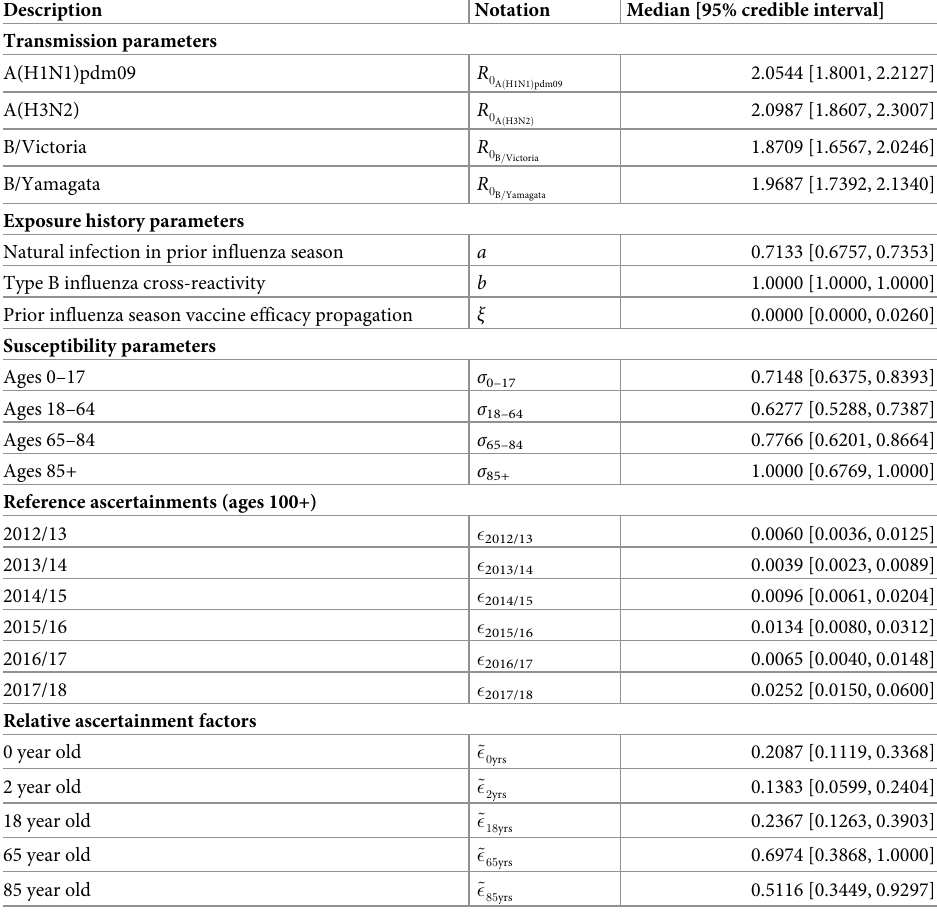
Table 6. Values for the basic reproduction number, exposure history, susceptibility and ascertainment probability parameters inferred fitting to the empirical data. Estimates computed from 100 particles. Numbers inside brackets indicate 95% credible intervals. All values are given to 4